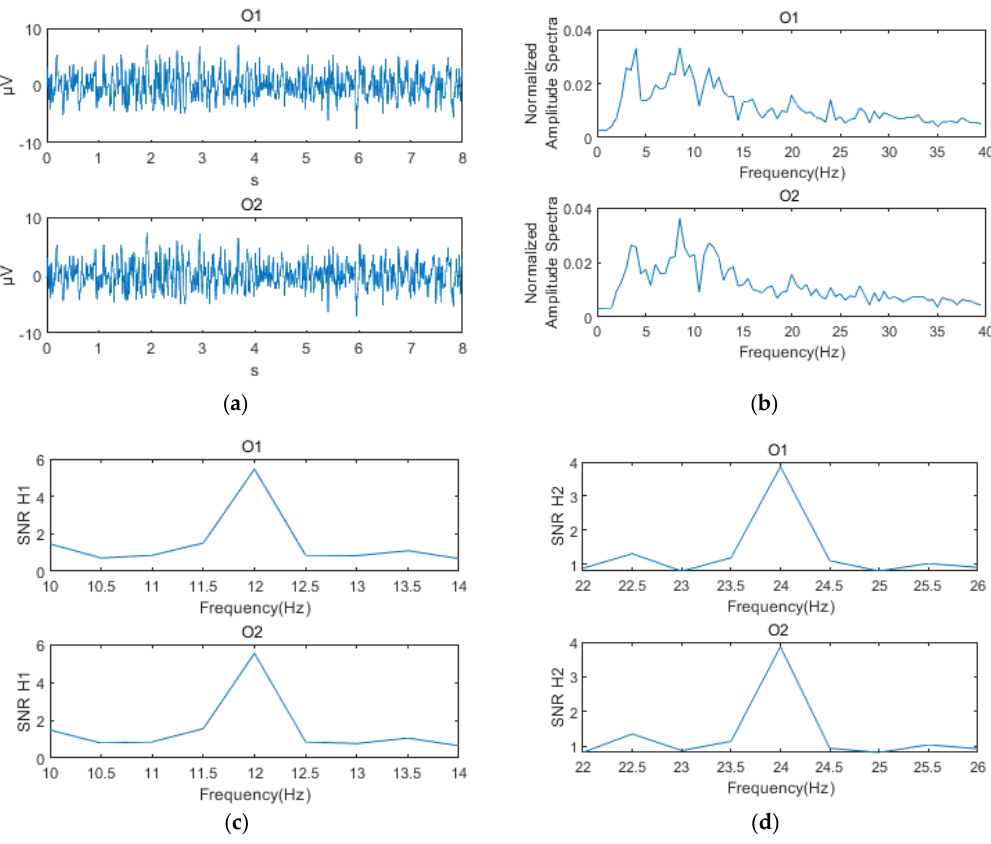
Figure 3. Stages in the processing of the temporal series to obtain the signal-to-noise ratio (SNR): ( a ) electroencephalographic (EEG) time course; ( b ) power spectral density; ( c ) harmonic (EEG) time course; ( b ) power spectral density; ( c ) harmonic 1 SNR; ( d ) harmonic 2 1 SNR; ( d ) harmonic 2 SNR.